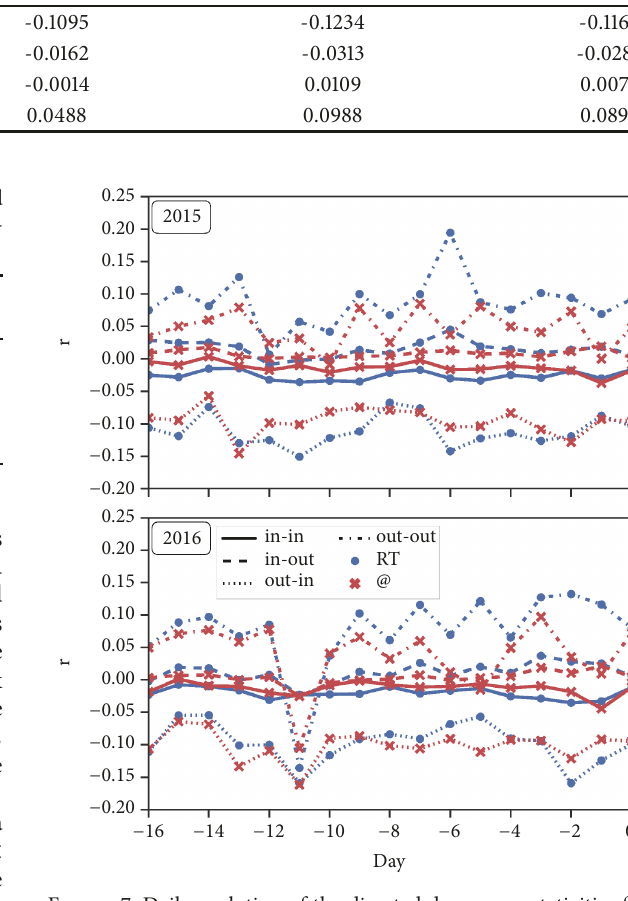
Figure 7: Daily evolution of the directed degree assortativities for mentions(@)andretweets(RT)networksforthe2015(top)and2016 (bottom) electoral